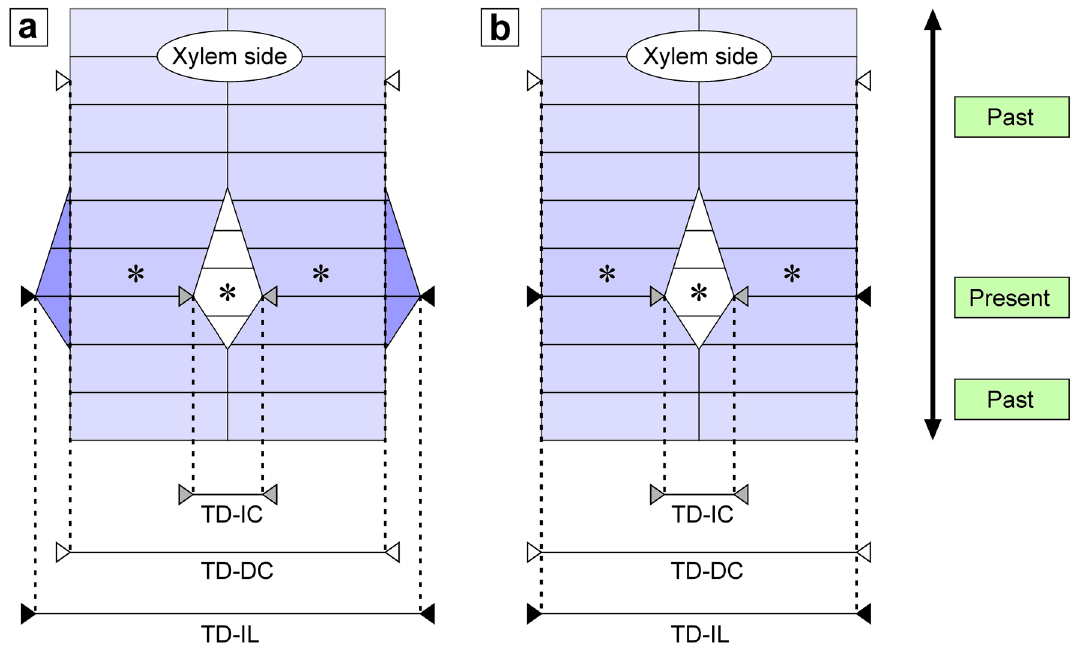
Figure 2. Schematic representations showing consequences of two hypotheses of intrusive growth of cambial initials. ( a ) Hypothesis no. 1: intrusive growth of a cambial initial cell has an impact on cambial circumference of a tree trunk. In this scenario (TD-DC < TD-IL) growth of an initial would be related to moving cells of neighbouring files apart in circumferential direction, thus contributing to an increase in the tangential dimension of this tissue fragment, as well as the whole circumference of a tree trunk. ( b ) Hypothesis no. 2: intrusive growth of an initial cell has no impact on the cambial circumference (TD-DC = TD-IL). Note the indication of a time aspect in reference to subsequently deposited layers of cambial derivative cells (green boxes on the right side). Radial enlargement of cells was not taken into account. Asterisks indicate cambial initials. TD-IC—tangential dimension of intrusively growing cambial initial cell measured within initial layer. TD-IL— tangential dimension of two radial files adjacent to intrusively growing initial cell together with tangential dimension of growing initial—measured in initial layer. TD-DC—tangential dimension of the same two radial files as in TD-IL, but distanced by several cells from initial layer. CorelDRAW Graphics Suite SE ver. 18.2.0.840 (https:// www. corel draw. com) was